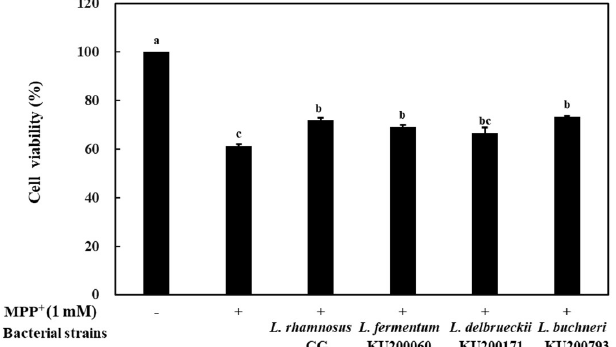
Figure 1. Neuroprotective e ff ect of conditioned medium (CM) on MPP + (1 mM)-stressed